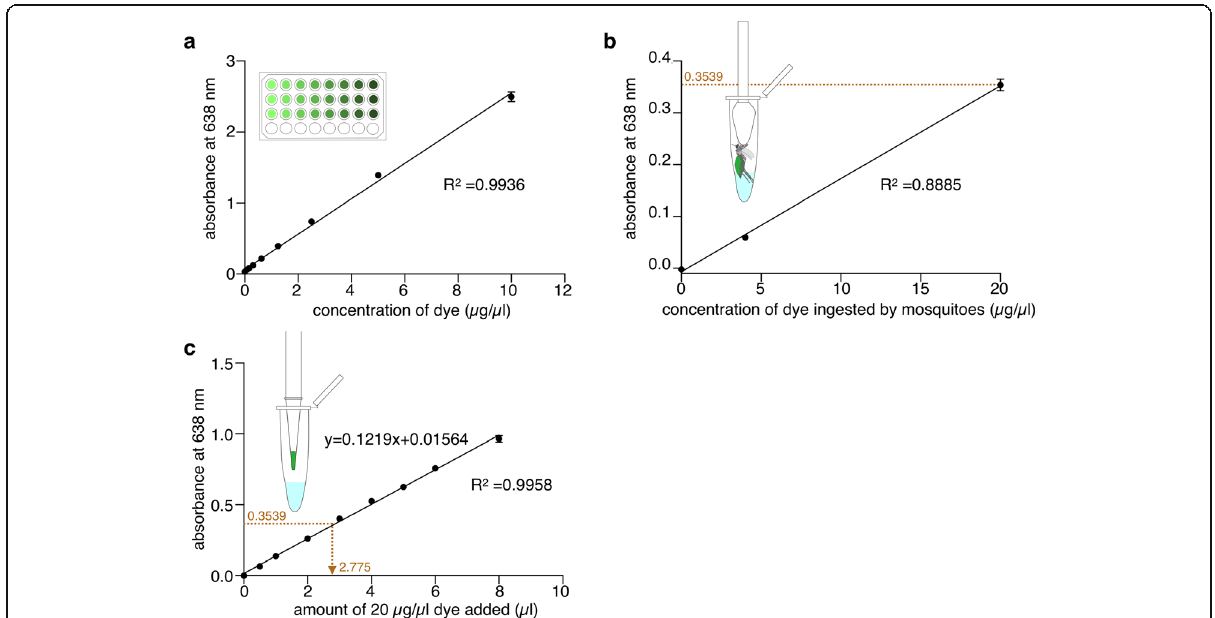
Fig. 3 Colorimetric quantification of ATP solution ingested by mosquitoes. a Absorbance at 638 nm of two-fold serial dilutions of green dye which was dissolved in ultrapure water. Two hundred microliter of each solution containing the indicated concentration of green dye was applied to a well of 96-well plate. Simple linear regression analysis was performed ( R 2 = 0.9936). b Absorbance at 638 nm of homogenized solution prepared from each Ae. aegypti female mosquito that sucked 0.1 mM ATP solution containing either 0 μ g/ μ l, 4 μ g/ μ l, or 20 μ g/ μ l of green dye. All experiments were performed more than three times. The numbers of mosquitoes used at each concentration of dye were 89, 83, and 74, respectively. All error bars show standard error of mean (SEM), and two bars in this figure were not visible due to the small values of SEM. Simple linear regression analysis was performed ( R 2 = 0.8885). The average absorbance of mosquitoes fed with ATP solution (20 μ g/ μ l green dye) was 0.3539. c Absorbance at 638 nm of PBS containing green dye. Each aliquot (0.5 – 8 μ l) of 20 μ g/ μ l green dye was added to a 1.5-ml